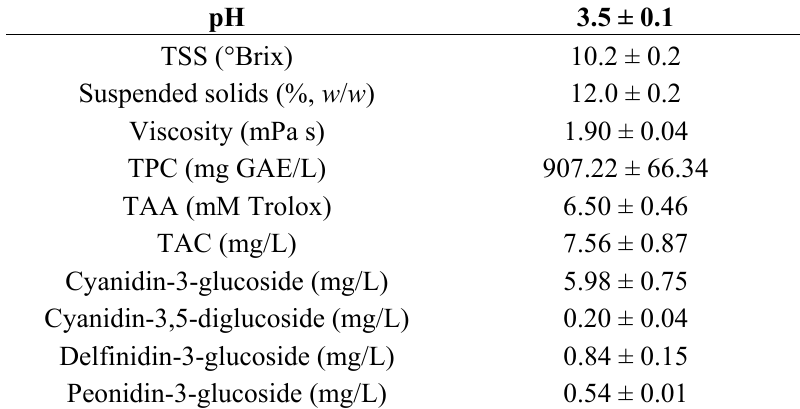
Figure 1. Ultrafiltration (UF) of blood orange juice. Effect of TMP on permeate flux (total recycle configuration; Q f , 100 L/h; T, 20 °C). Table 2. Physicochemical characterization of depectinized blood orange juice.